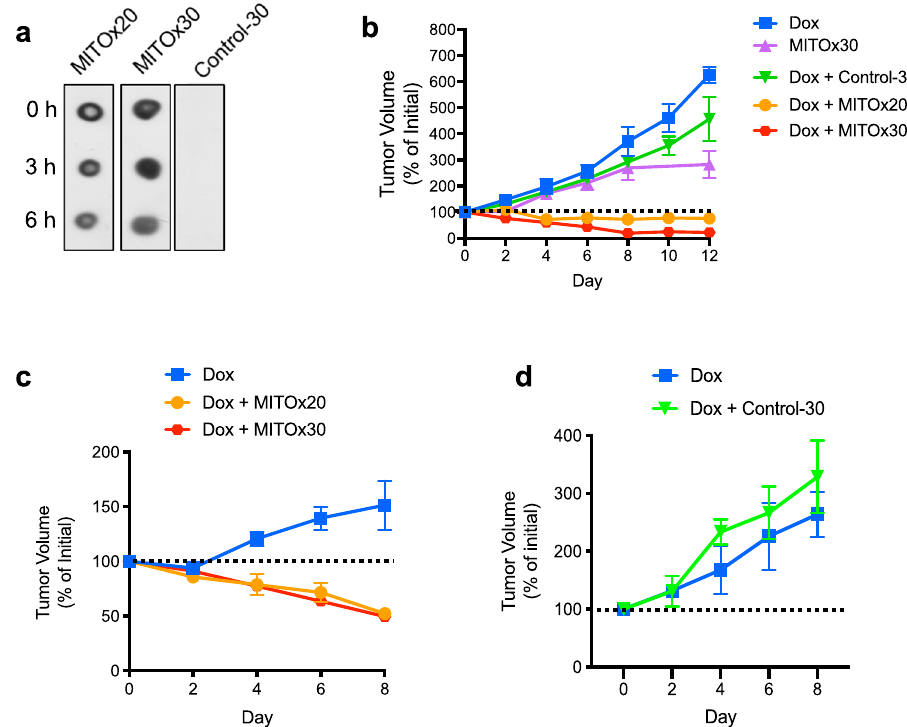
Fig. 7 Reversal of chemotherapy resistance in mouse models of chemoresistant cancer. a Spot blot analysis of MITOx20, MITOx30, and Control-30 prior to (0 h) or after incubation with serum (3 or 6 h) using an antibody speci fi c for the N-terminus of MCJ. b MCJ-de fi cient MMTV-PyMT mice were treated with doxorubicin alone (Dox, n = 5), MITOx30 alone ( n = 4), or doxorubicin in combination with Control-30 ( n = 4), MITOx20 ( n = 6), or MITOx30 ( n = 5) every other day for 12 d. Change in tumor volume over time during treatment relative to the initial tumor size is shown. p = 0.0001. c NSG mice with NCI/ADR-RES cell xenografts were treated with doxorubicin alone or in combination with MITOx20 or MITOx30 every other day for 8 d ( n = 6). Change in tumor volumes over time during treatment relative to the initial tumor size is shown. p = 0.0001. d NSG mice ( n = 4 per group) with NCI/ ADR-RES cell xenografts were treated with doxorubicin alone or in combination with Control-30 as in ( c ). For b – d repeated measures analysis of variance was used to examine the trajectory of tumor volume over time, and statistical signi fi cance for all post hoc tests were subject to Bonferroni correction to control for multiple comparisons. Mean ± SEM provided for all fi